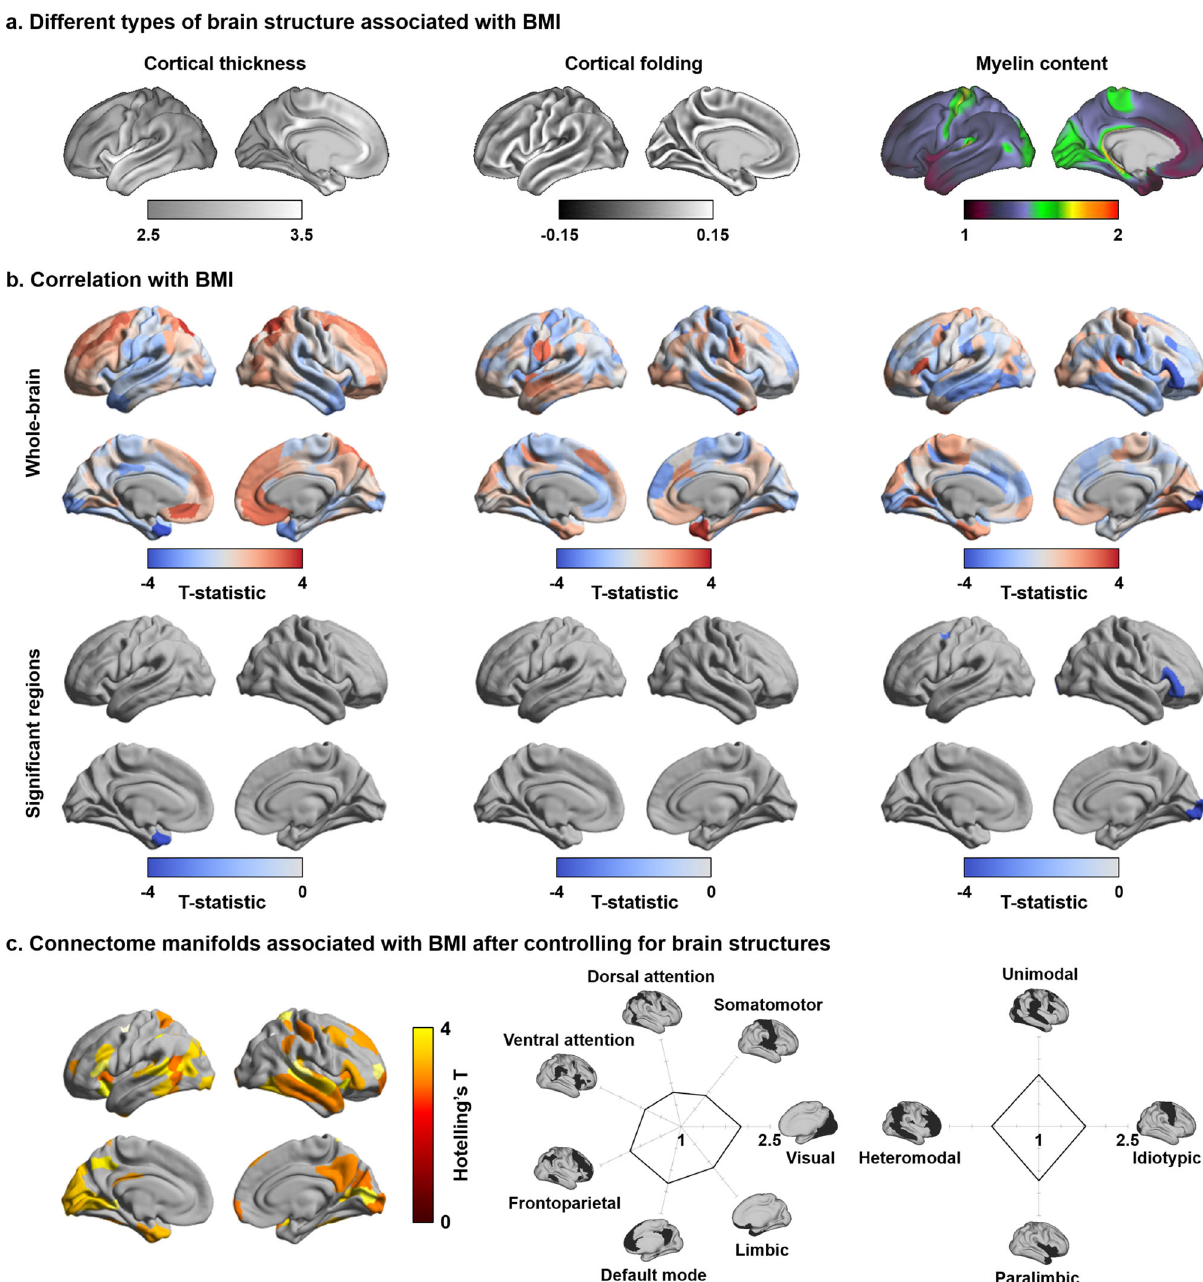
Fig. 2 Effects of brain structures. a MRI measures of brain structure, including cortical morphology and intracortical microstructure were obtained in the same participants. b Linear correlations between inter-individual variations in BMI and these indices of brain structure. c Multivariate association of the three functional eigenvectors with BMI, after controlling for variations in brain structure. Source data are provided in Supplementary Data